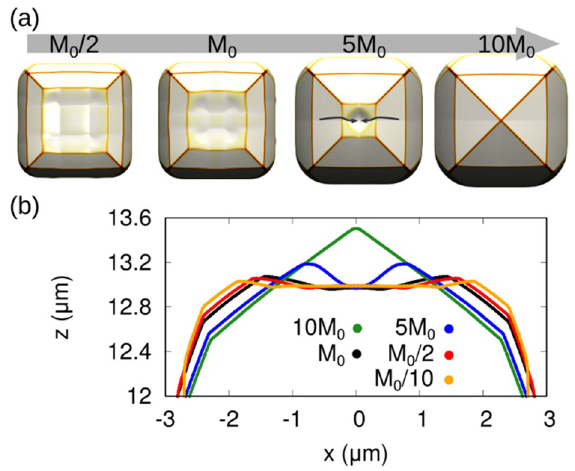
Figure 4. Simulations of the effect of the surface mobility on the faceting. ( a ) Top view of Si microcrystal (5 μm tall). The initial Si width is 4 μm for the growth of Si. ( b ) The cross-sectional surface profile of the simulations in ( a ) highlighting the tendency to transfer material from the {113} to cover the (001)